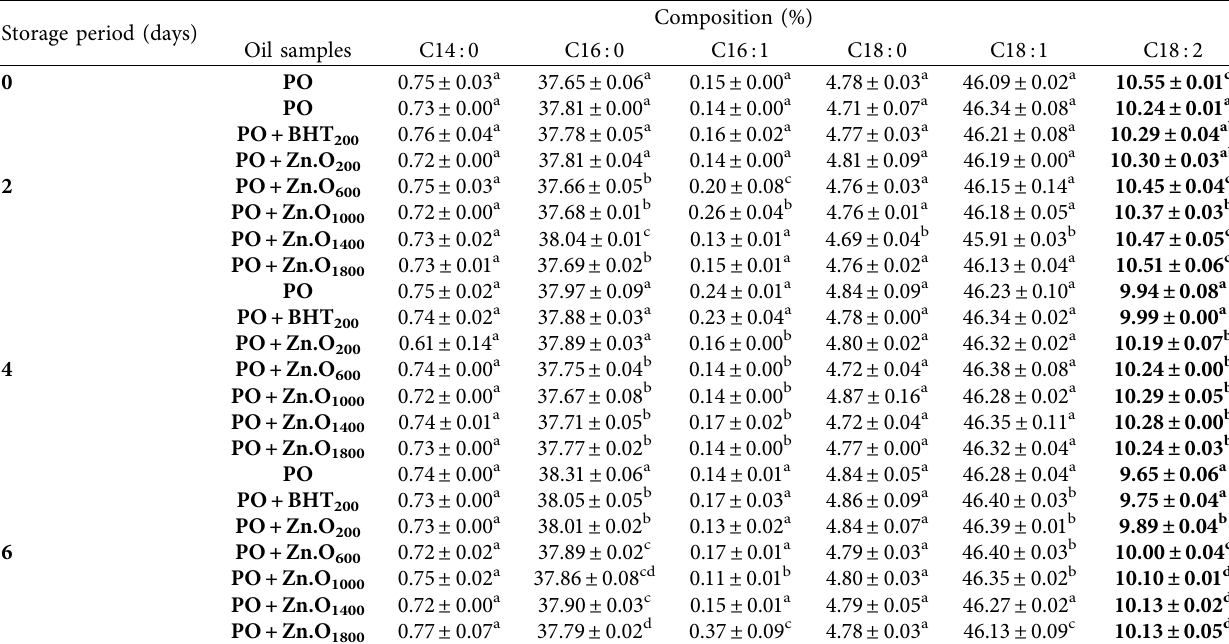
Table 1: Variations in fatty acid composition of palm olein